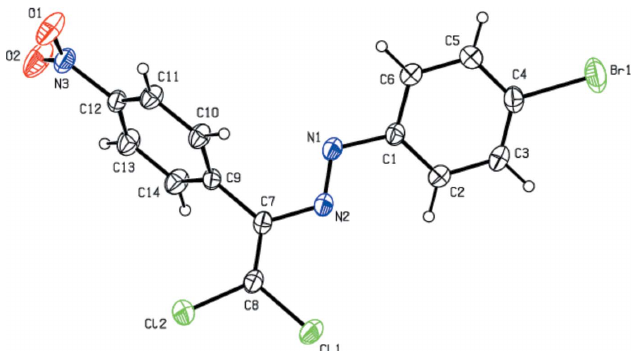
Figure 1 The molecular structure of (I) with displacement ellipsoids drawn at the 30% probability level.